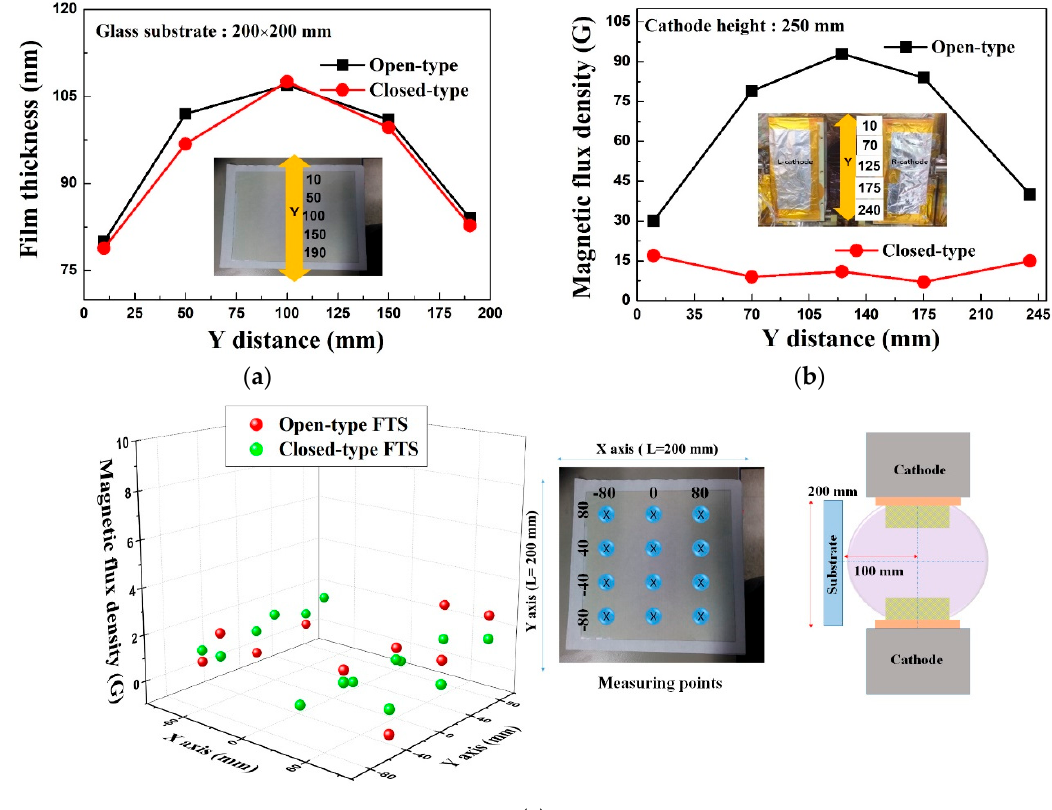
Figure 3. Distribution of magnetic flux density between two targets as a function of the arrangement of permanent magnets in cathode (Y: perpendicular direction). ( a ) Open-type Facing Targets Sputtering (FTS), ( b ) Closed-type FTS, and ( c ) magnetic flux density measured on the surface of the substrate.